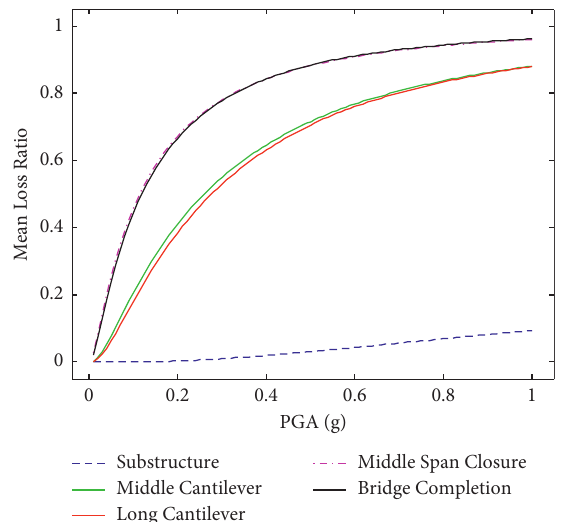
Figure 9: Seismic mean loss ratio curves of different construction